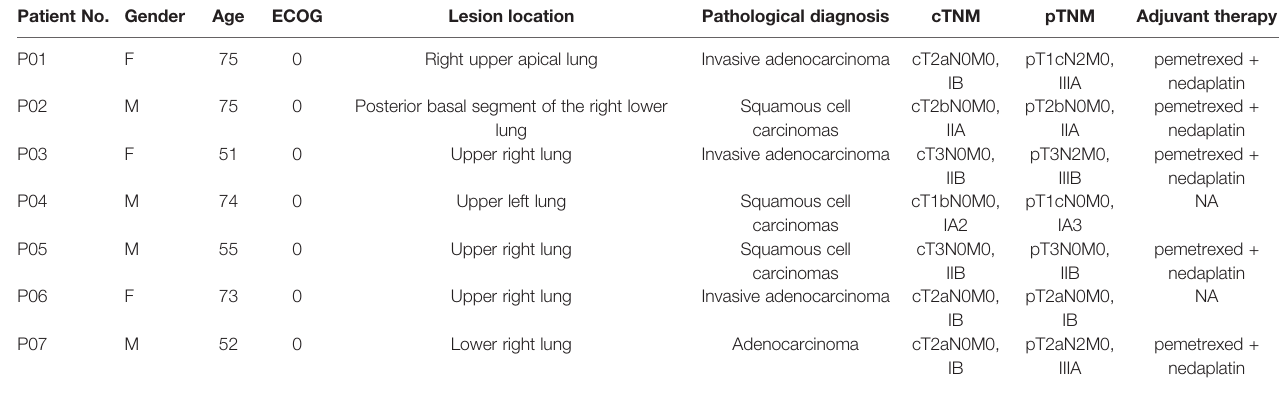
TABLE 1 | Basic information of participants. Patient No.